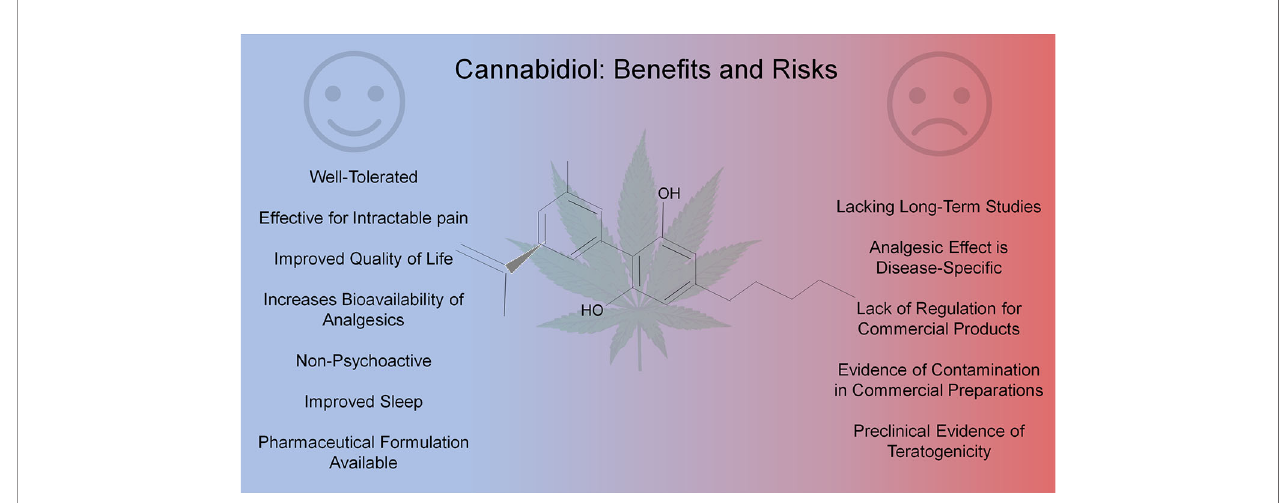
FIGURE 1 | Pros and cons of cannabidiol use in chronic